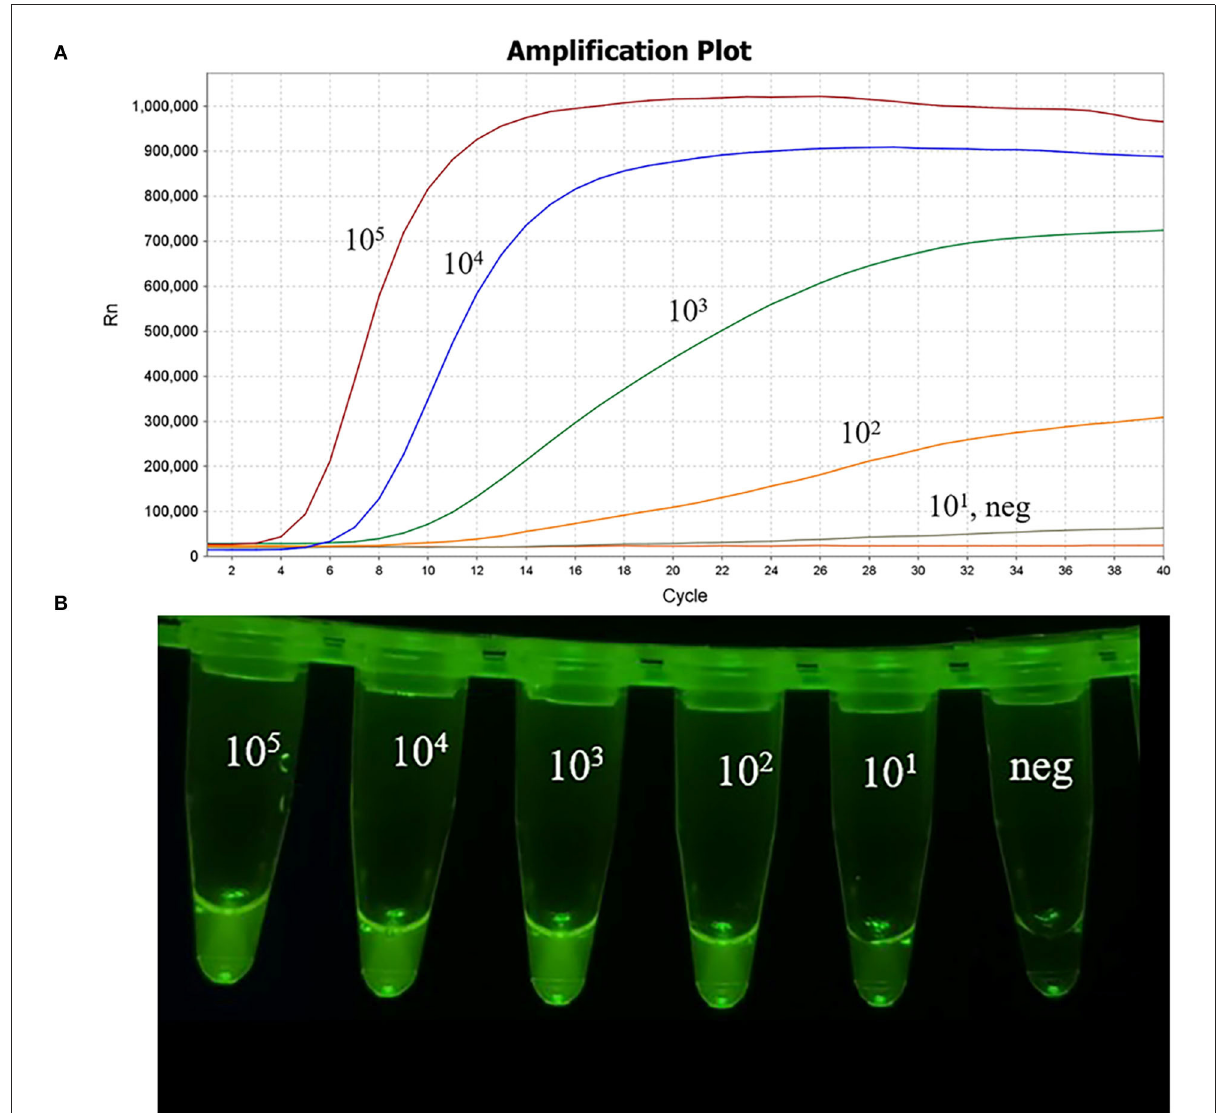
FIGURE5 Sensitivity of the MIRA assay. The 10-fold dilutions of plasmid pMD-19T-Cap as the template for the MIRA assay. (A) The amplification results of MIRA combined with fluorescence read-out. Curves, 10 5 to 10 1 copies/ µ L of PCV4 plasmid DNA and neg, negative control of RNase-free ddH 2 O. (B) Direct visual observation under UV light of the amplification products of MIRA. Tubes, from left to right, nucleic acid templates corresponding to 10 5 to 10 1 copies/ µ L of PCV4 plasmid DNA; neg, negative control of RNase-free ddH 2 O,